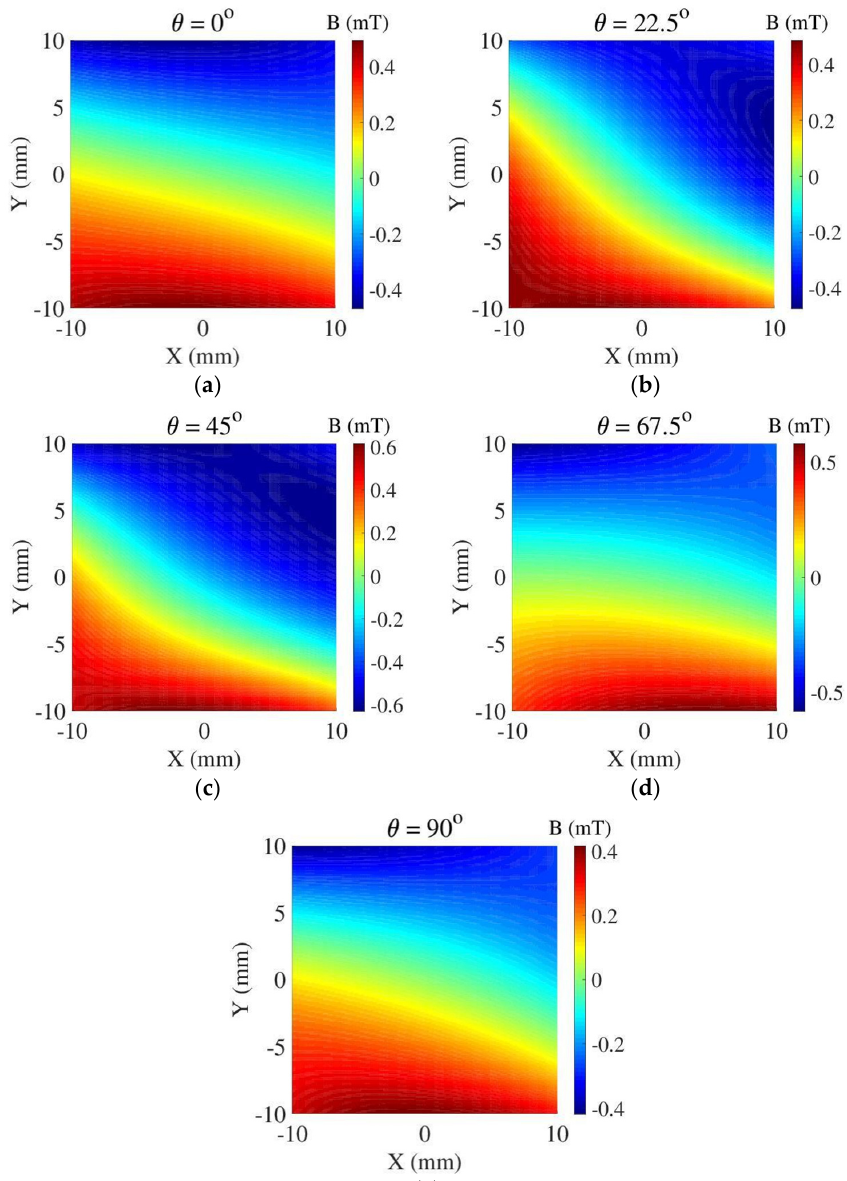
Figure 8. Distribution of surface magnetic induction B when the magnetic field was 3000 A/m and electromagnet poles placed at different angles of ( a ) 0°, ( b ) 22.5°, ( c ) 45°, ( d ) 67.5°, and ( e ) 90° for specimen 1.